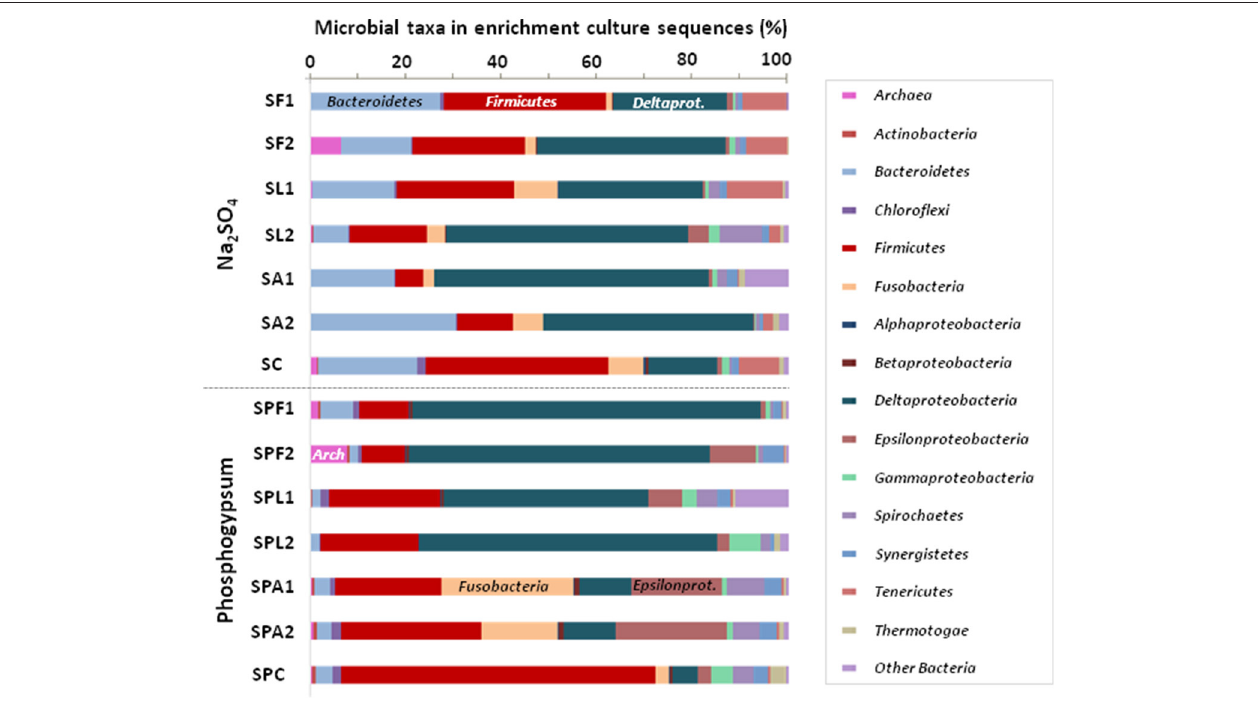
FIGURE 3 | Compositions of microbial communities in sulfate-reducing enrichment cultures from marine sediment using different electron donors and sulfate sources after 14 days. Relative phylogenetic abundance was based on frequencies of 16S rRNA gene sequences affiliated with Archaea and major bacterial phyla or proteobacterial classes in the microbial communities. The names of enrichment cultures (duplicates 1 and 2) have been abbreviated as follows: SF, SL, SA, and SC for Na 2 SO 4 enrichment cultures with formate, lactate, acetate and without electron donor, respectively; SPF, SPL, SPA, and SPC for PG enrichment cultures with formate, lactate, acetate, and without electron donor, respectively.